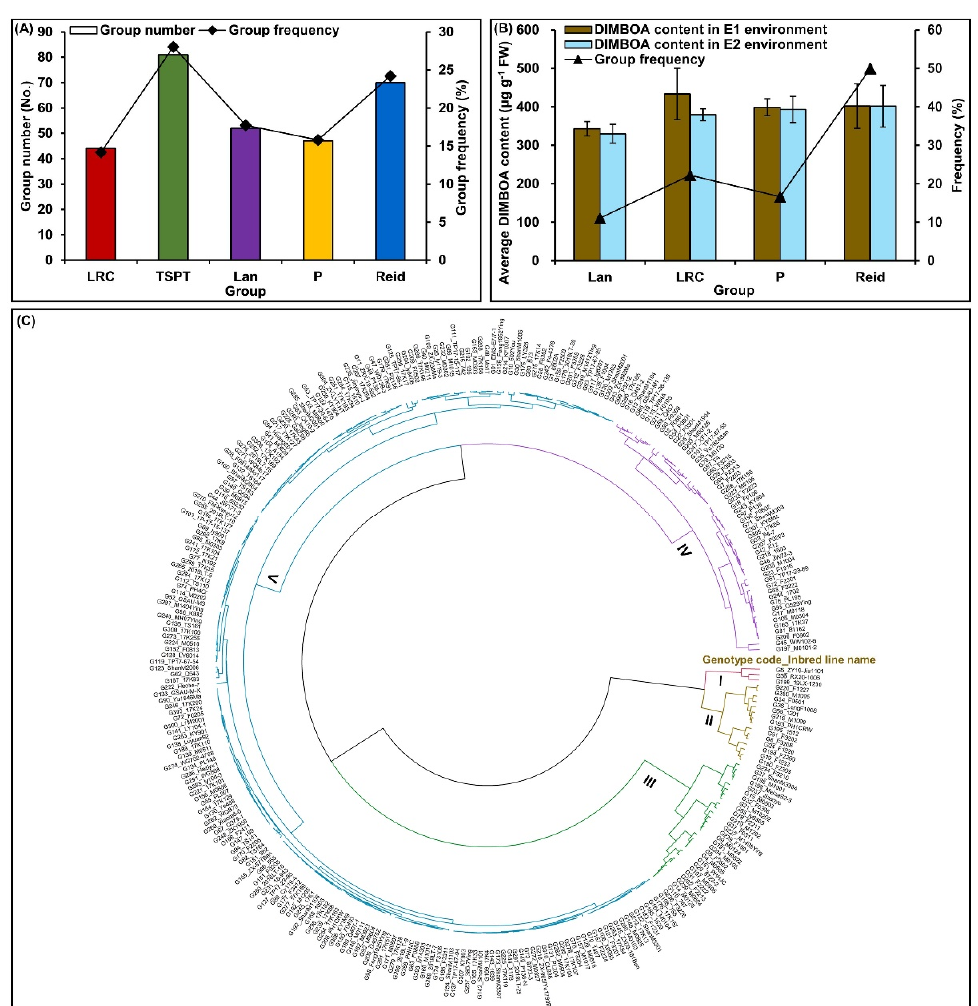
Figure 3. Evaluation of multiple insect-resistance among 310 maize inbred lines in both Zhangye (E1) and Longxi (E2) ecological environments by unweighted pair-group method with arithmetic means (UPGMA) cluster analysis, and their attributive group dissection. ( A ) Statistics for group number and frequency of each optimal group. ( B ) Attributive groups and their frequency distribution of three high insect-resistant and 15 moderate insect-resistant inbred lines; average of DIMBOA content for each attributive group (including Lüda red cob (LRC), Lancaster (Lan), P, and Reid group, respectively) in E1 and E2, respectively. ( C ) Evaluation of multiple insect-resistance among 310 inbred lines in two environments were performed using R package (http://www.R-project.org/; accessed on 20 April 2022) with UPGMA (the K value sets to 5), including type I (high insect ‐ resistant lines), type II (moderate insect ‐ resistant lines), type III (insect ‐ resistant lines), type IV (moderate insect ‐ susceptible lines), and type V (insect ‐ susceptible lines), respectively.